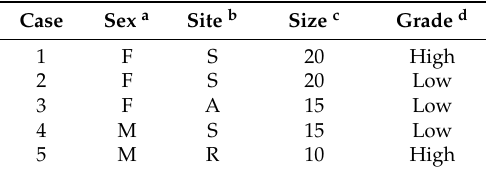
Table 2. Clinicopathological features in colorectal adenoma